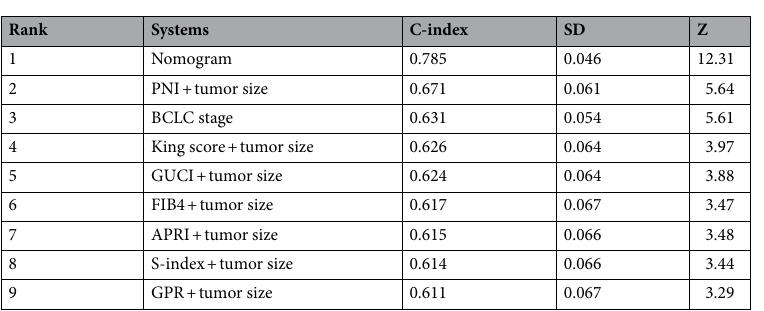
Table 4. Ranking of discriminatory ability of the prognostic systems on the basis of C-index. C-index reflects the ability to predict survival: the greater the C-index, the more accurate the prognostic prediction.